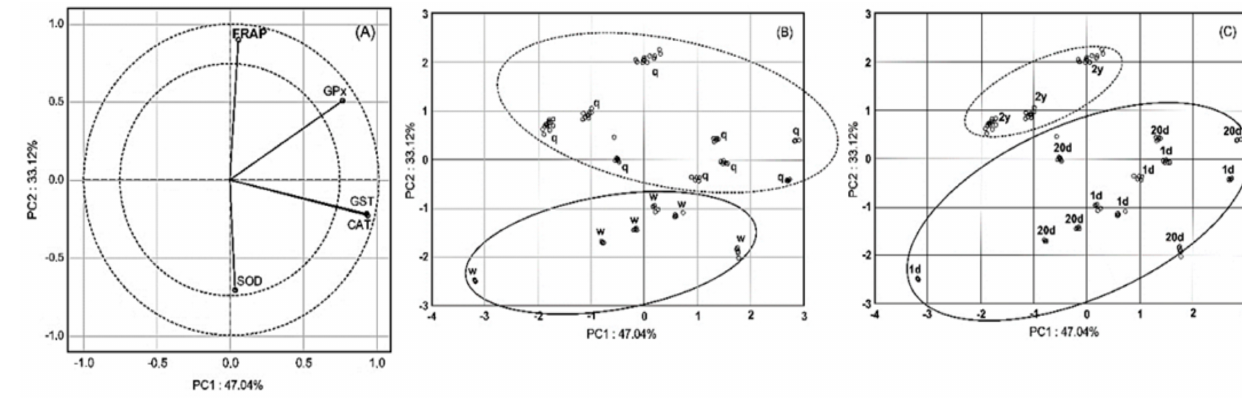
Figure 3. Principal component analysis (PCA): ( A ) two-dimensional projection catalase (CAT), glutathione peroxidase (GPx), glutathione S-transferase (GST), superoxide dismutase (SOD), and ferric reducing antioxidant potential (FRAP) in the principal components PC1 and PC2; ( B ) projection of workers (w; solid) and queens (q; dotted) in the principial components PC1 and PC2; ( C ) two-dimensional projection of the age classes (dotted–2-year-old; queens only, solid–1-day-old and 20-day-old insects in the principal components PC1 and PC2